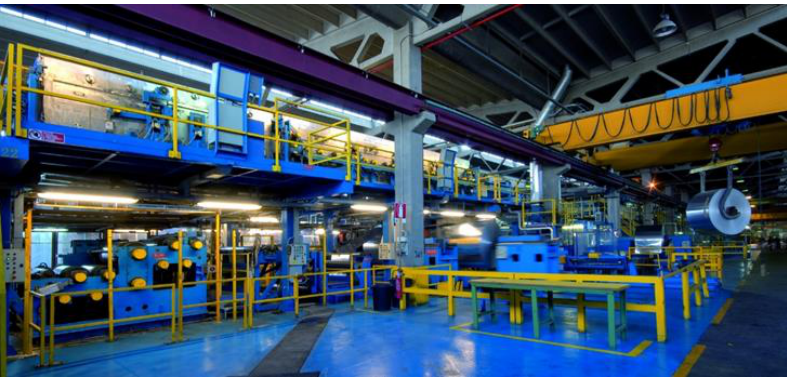
Figure 3. The Laminazione Sottile S.p.A no-rinse conversion-coating plant. In conclusion, the no-rinse process shows several benefits and few drawbacks, com- pared to the rinse one, as reported in Table 1.